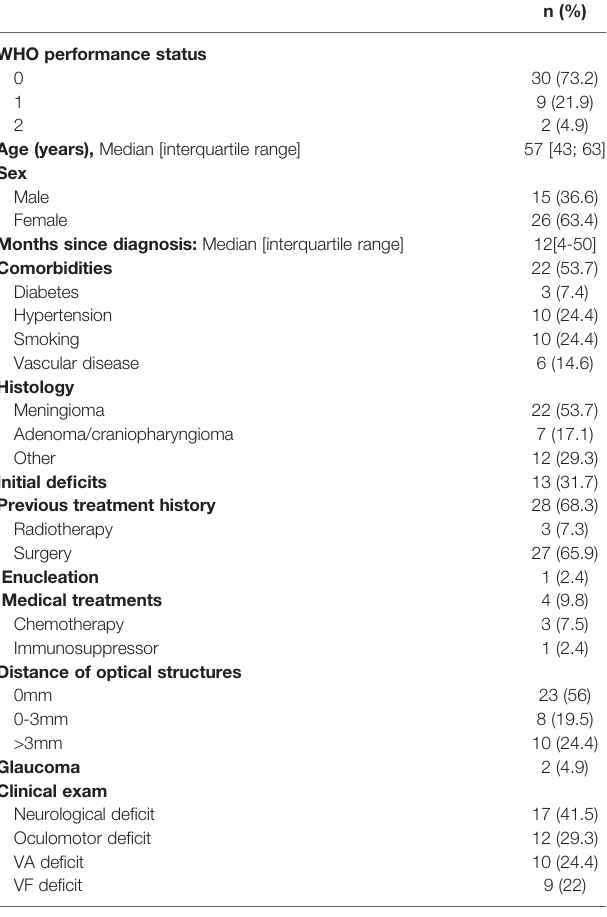
TABLE 1 | Population baseline characteristics.